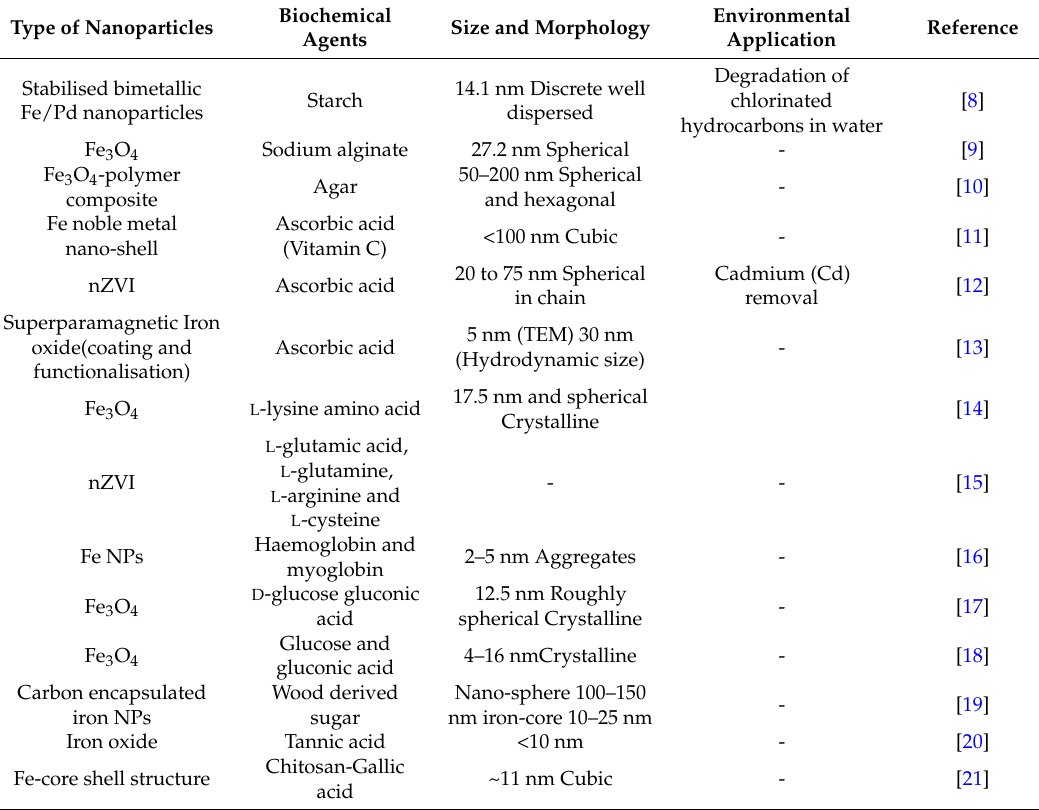
Table 1. Size, morphology and environmental application of Fe 0 /Fe 2 O 3 /Fe 3 O 4 nanoparticles synthesised by biocompatible green